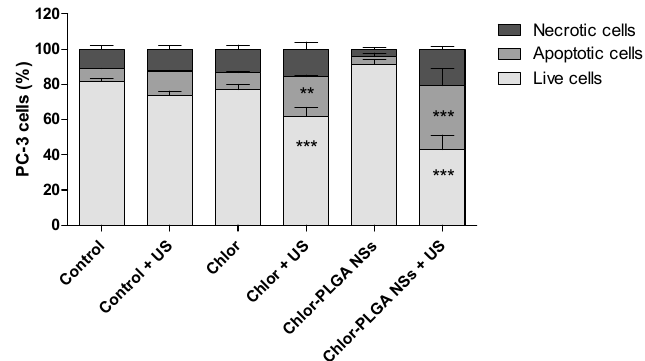
Figure 8. Induction of cell apoptosis on PC-3 cells after sonodynamic treatment with Chlor and Chlor- PLGA NSs. PC-3 cells were exposed to Chlor, Chlor-PLGA NSs (5 µM) for 24 h and then where required underwent to US exposure (1.5 MHz for 5 min at 1.5 W/cm 2 ) or left untreated. Apoptosis assays were carried out by flow cytometry, following APC-Annexin V and PI staining. A percentage of apoptotic cells (positive to APC-Annexin V and negative to PI) and necrotic cells (positive to APC- Annexin V and PI) and live cells (negative to APC-Annexin V and PI) was evaluated 24 h after treatment. Statistical significance vs. untreated cells (i.e., control): ** p < 0.01, and *** p < 0.001.